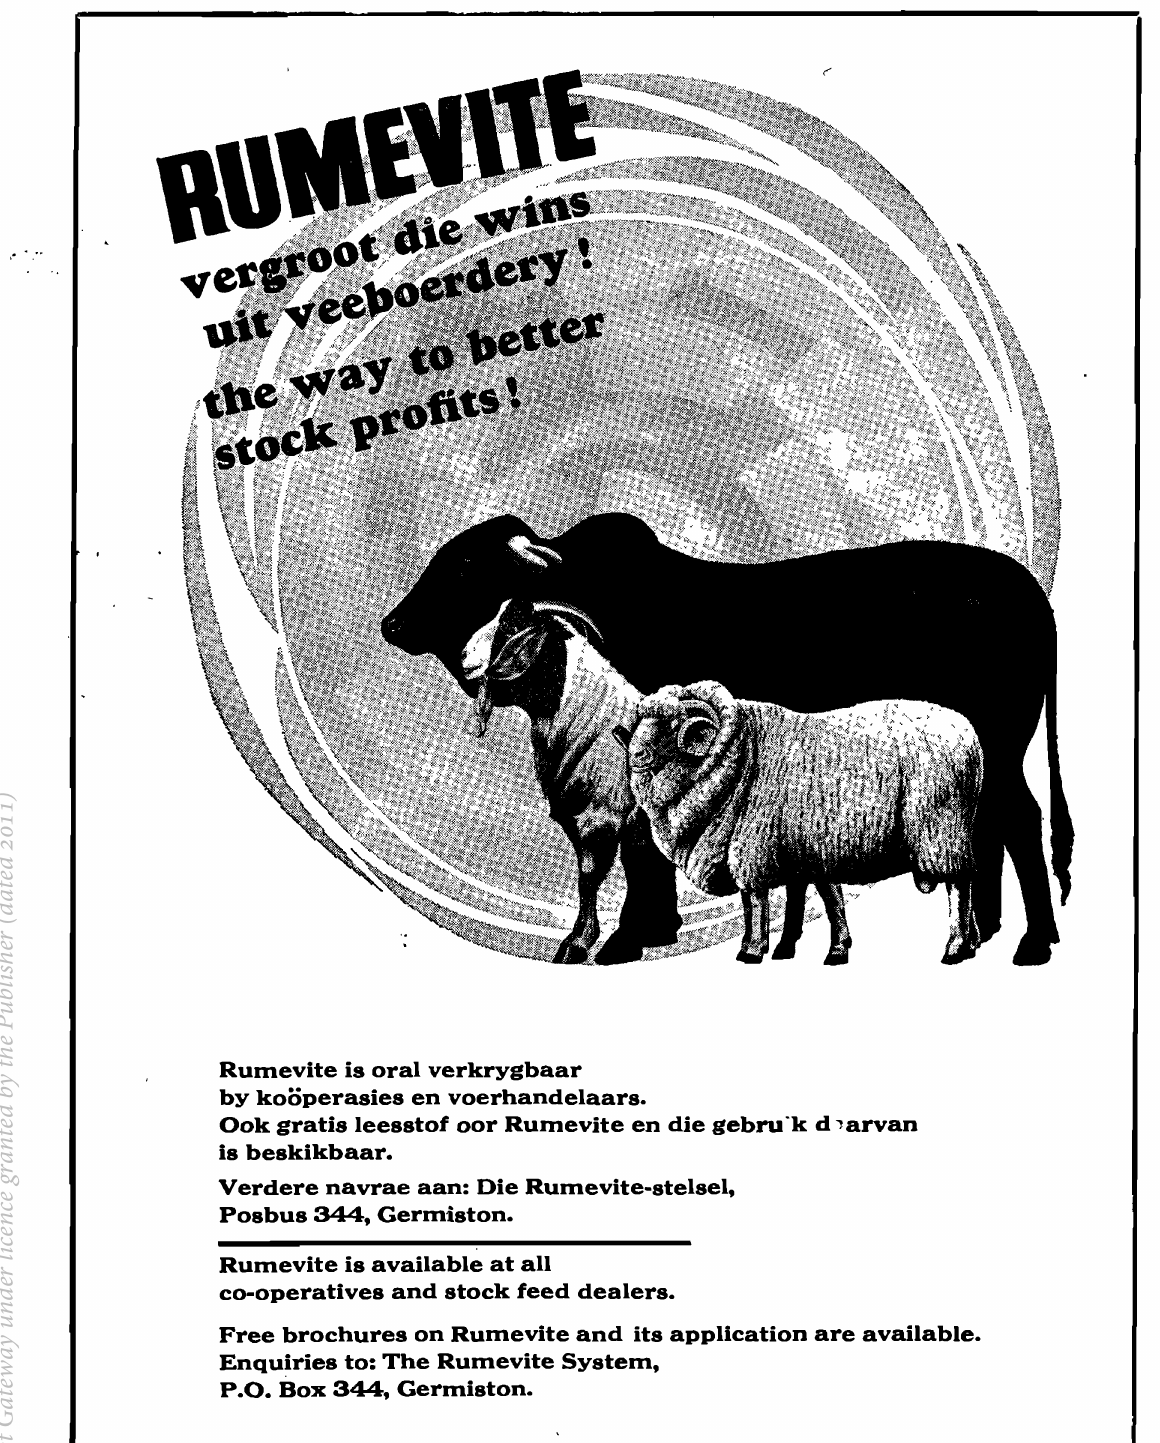
Rumevite is oral verkrygbaar by kooperasies en voerhandelaars. Ook gratisleesstof oor Rumevite en die gebru-k d 'arvan is beskikbaar. Verdere navrae aan: Die Rumevite-stelsel, Posbus 344,